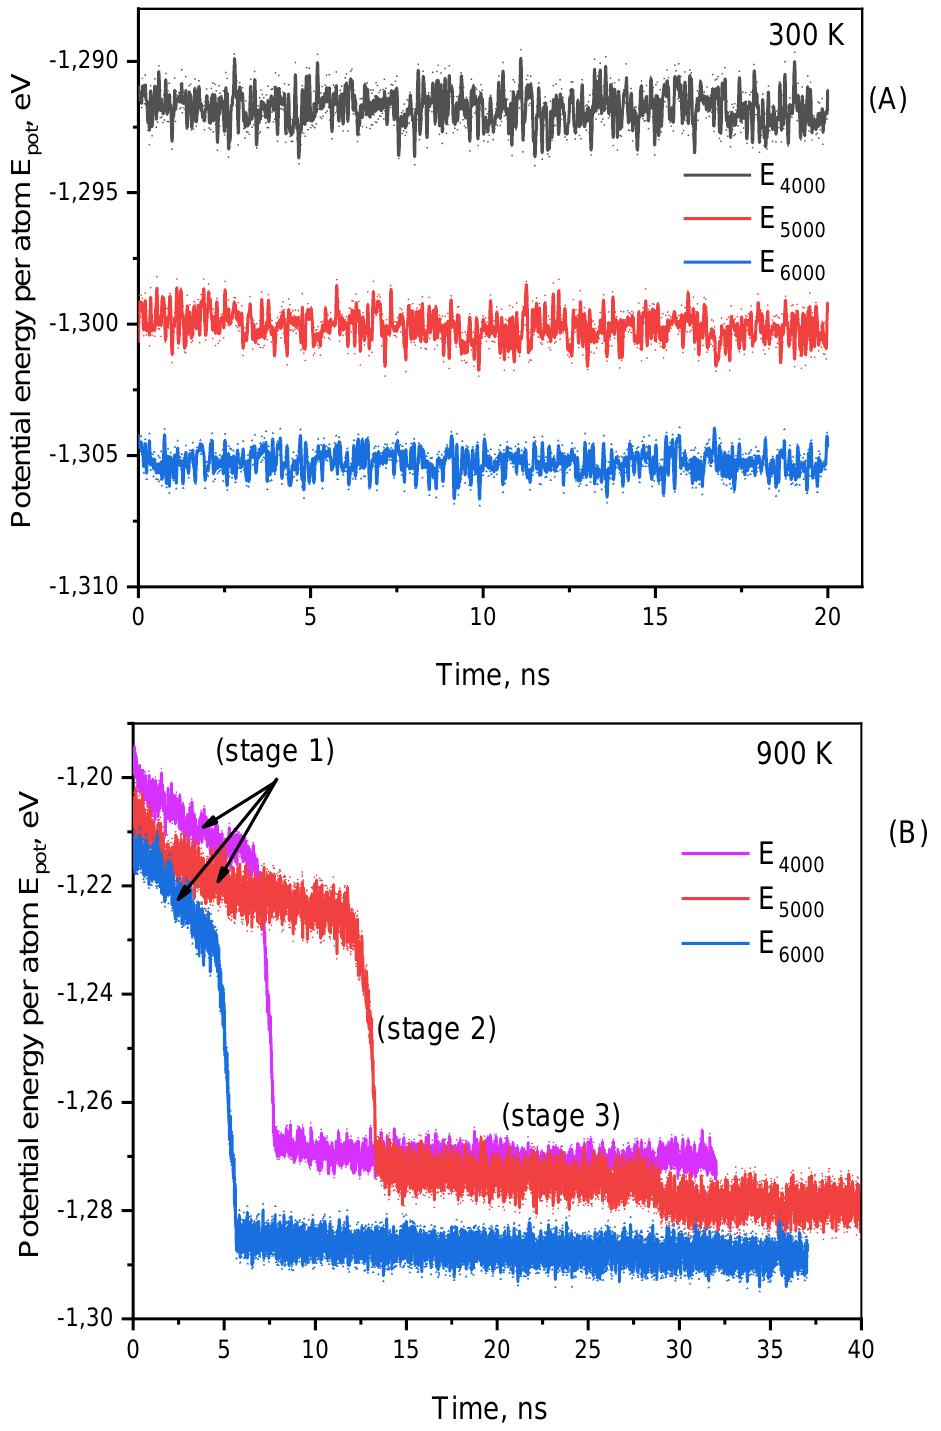
Figure 5. Potential energy per atom as a function of annealing time 4000, 5000, 6000 atoms sample at 300 and 900